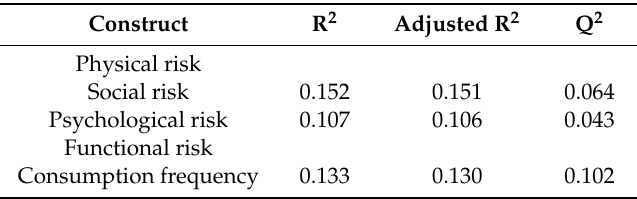
Table 8. Coe ffi cient determination (R 2 ), Adjusted R 2 and Q